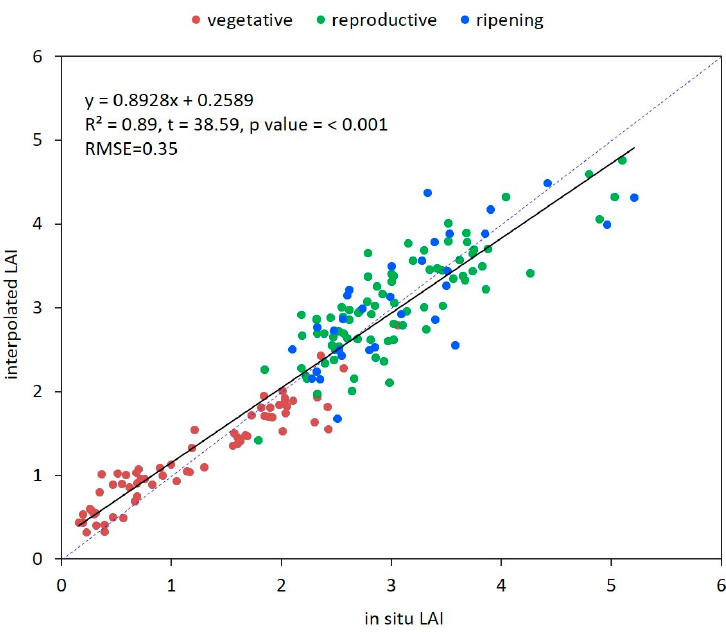
Figure 3. Linear relationship between in situ and interpolated LAI. The blue dashed line is the 1:1 line.